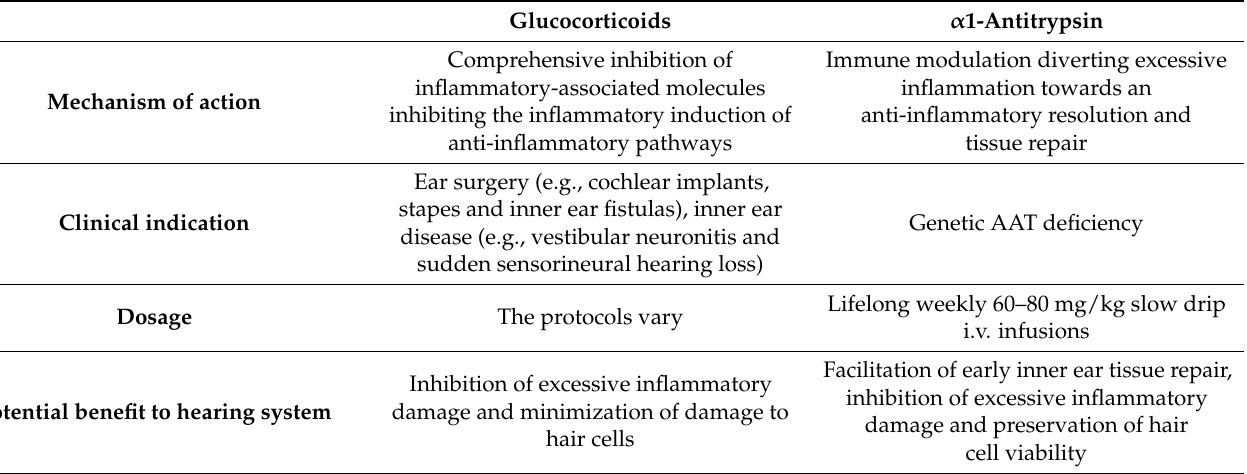
Table 1. Comparison between glucocorticoids and AAT . Mechanism of action, clinical indication, dose and relevance to